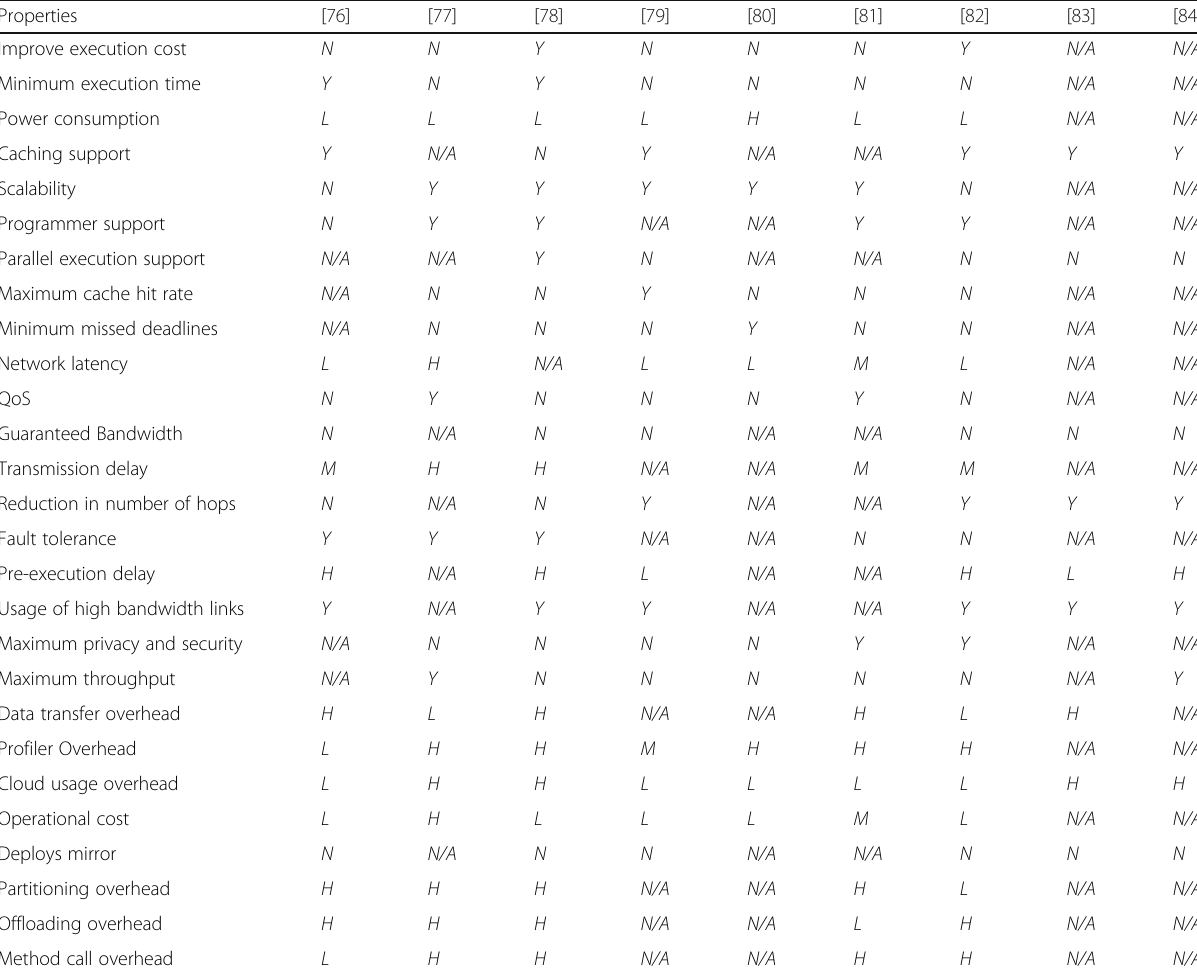
Table 5 Comparison of existing frameworks